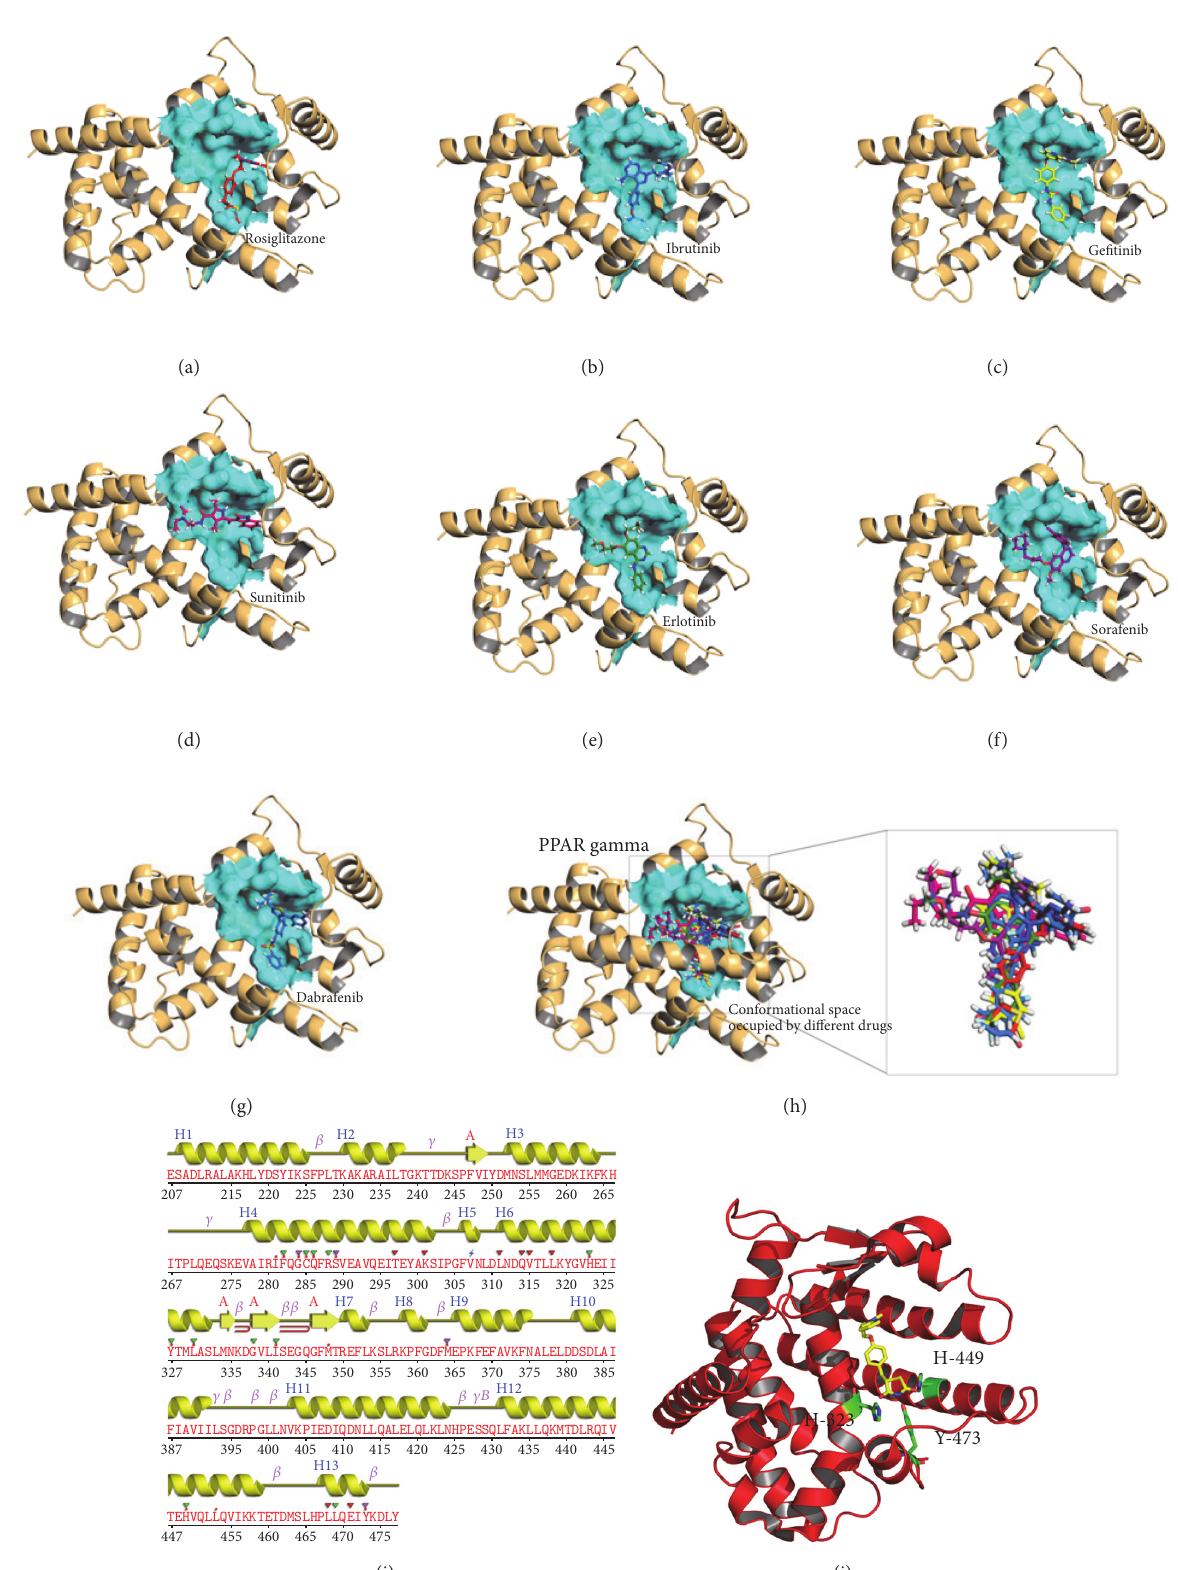
Figure 3: Postdocking interactions between active site residues of PPAR gamma with ligand ((a) rosiglitazone, (b) ibrutinib, (c) sorafenib, (d) sunitinib, (e) erlotinib, (f) gefitinib, and (g) dabrafenib). (h) Binding from all the poses obtained from all the drugs used in this study. The protein is depicted in cartoon and surface representation view and ligands as sticks in the binding pocket. (i) Secondary structure of 2PRG with amino acid residues mapped obtained using PDBSum program. (j) Crystal structure of PPAR gamma with rosiglitazone showing the position of His323, His449, and Tyr473 from helices 5, 7, and 12,